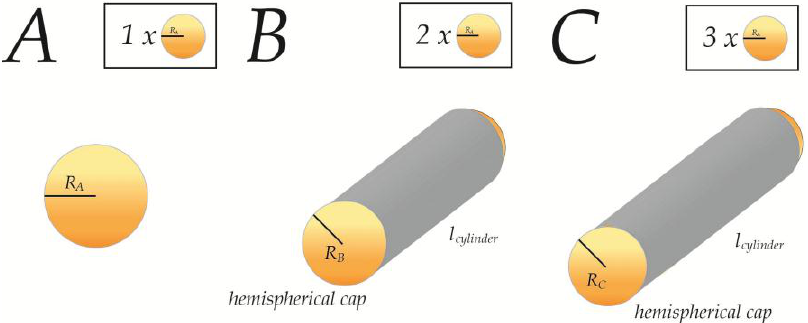
Figure 10. Formation of tubular carriers through homotypic fusion. A spherical membrane compartment A undergoes homotypic fusion with another similar spherical compartment, and yields a tubular fusion product B , where the radius decreases slightly to accommodate morphological changes as a result of insufficient volume. Fusion with another spherical compartment A yields the triple fusion product C . Both fusion products are defined as tubes consisting of two hemispherical caps spanned by a cylindrical part.